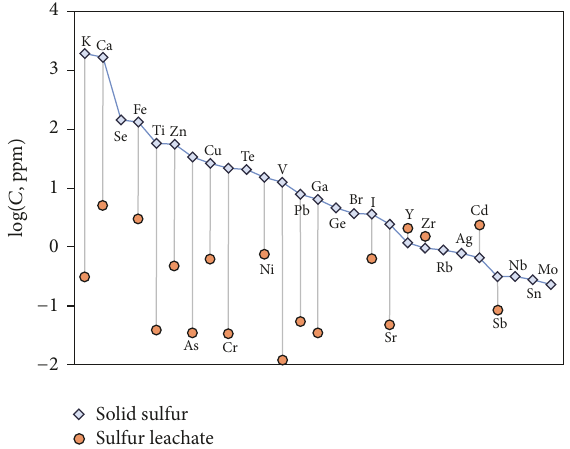
Figure 5: Average elemental concentrations in solid sulfur (July fumarolic field) compared to corresponding elemental concentra- tions in sulfur leachates from the same field. Elements are arranged from high to low average concentrations in